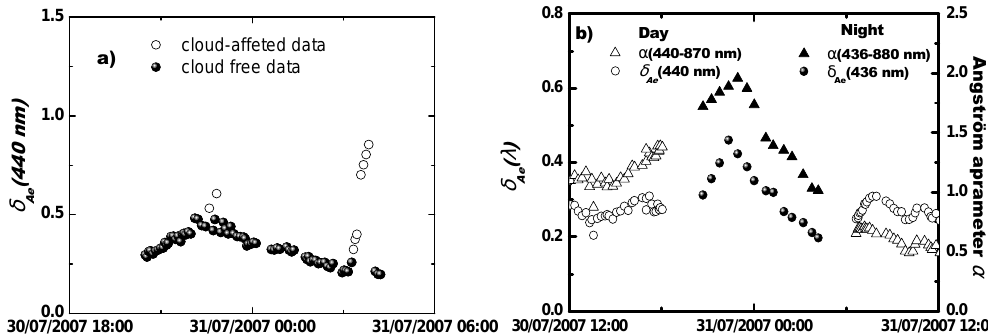
Fig. 9. (a) Nighttime evolution of aerosol optical depth during biomass burning event over the city of Granada on the night 30–31 July 2007. (b) Day-and-night time evolution of aerosol optical depth and Angstr¨om parameter α from 30 to 31 July 2007, after applying the cloud Figure 9: a) Night-time evolution of aerosol optical depth during biomass burning event over screening algorithm presented in this work to the nighttime the city of Granada on the night 30-31 July 2007. b) Day-and-night time-evolution of aerosol optical depth and Angström parameter a from 30 to 31 July 2007, after applying the cloud screening algorithm presented in this work to the night-time data